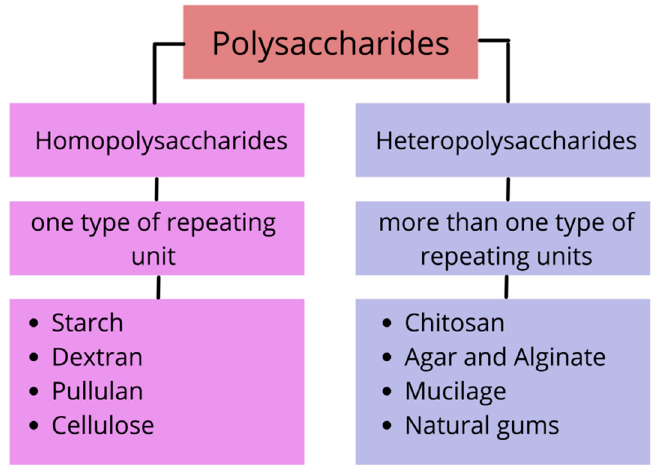
Figure 1. Classification of polysaccharides as an edible coating.